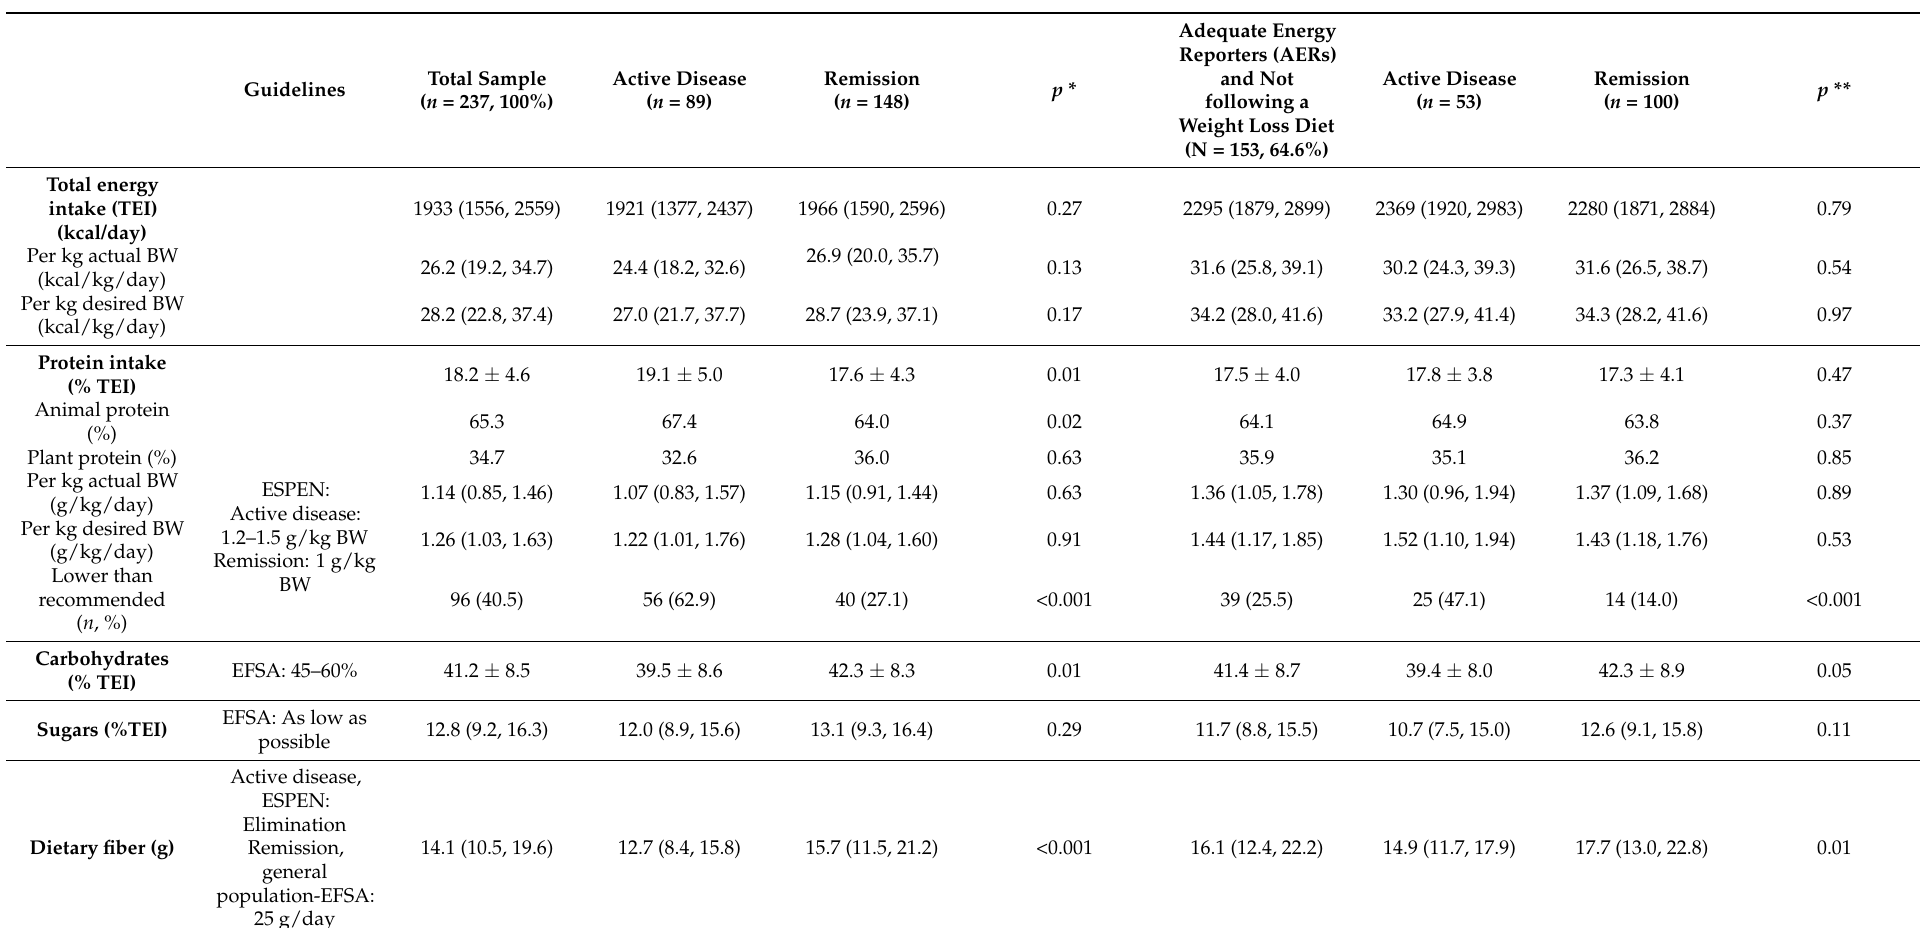
Table 2. Energy and macronutrients intake for 237 patients with Crohn’s disease in the total sample and in adequate energy reporters not on a weight loss diet and according to disease